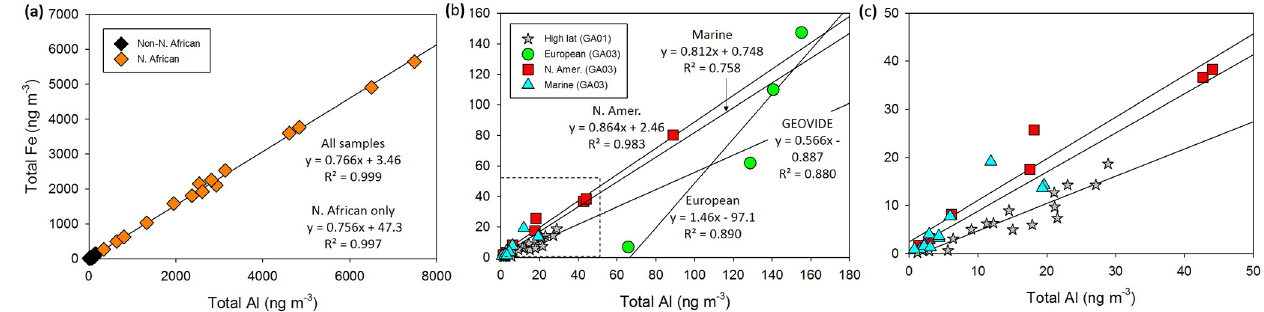
Figure 2. Total aerosol Fe and Al (ngm − 3 ) for (a) all aerosol samples from cruises GA01 and GA03, (b) samples from sources other than North Africa (i.e. the black diamonds in a ), and (c) the samples inside the dashed box in (b) . For High Latitude dust n = 18, European samples n = 4, North American samples n = 8, Marine samples n = 12, and Saharan samples n = 15. Note that error bars (standard deviations shown in Table S1) are not included so as not to obscure the